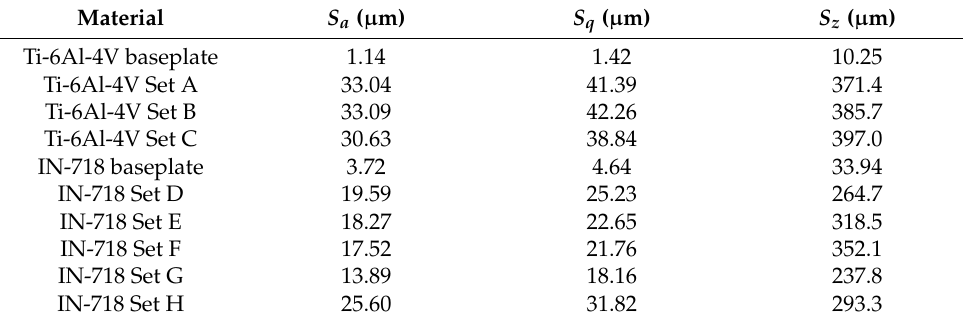
Table 2. DED-AM build sequence with laser ultrasound (LU) testing.